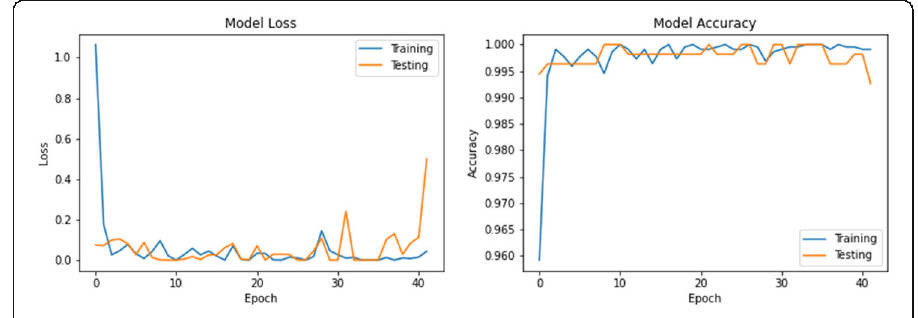
Fig. 9 VGG19 accuracy loss graph